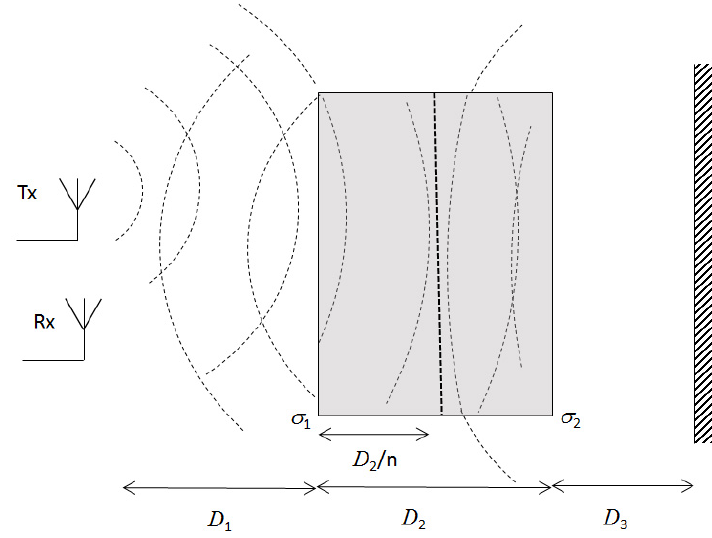
Figure 2. Illustration of the different path loss effects that affect the amplitude of the measured